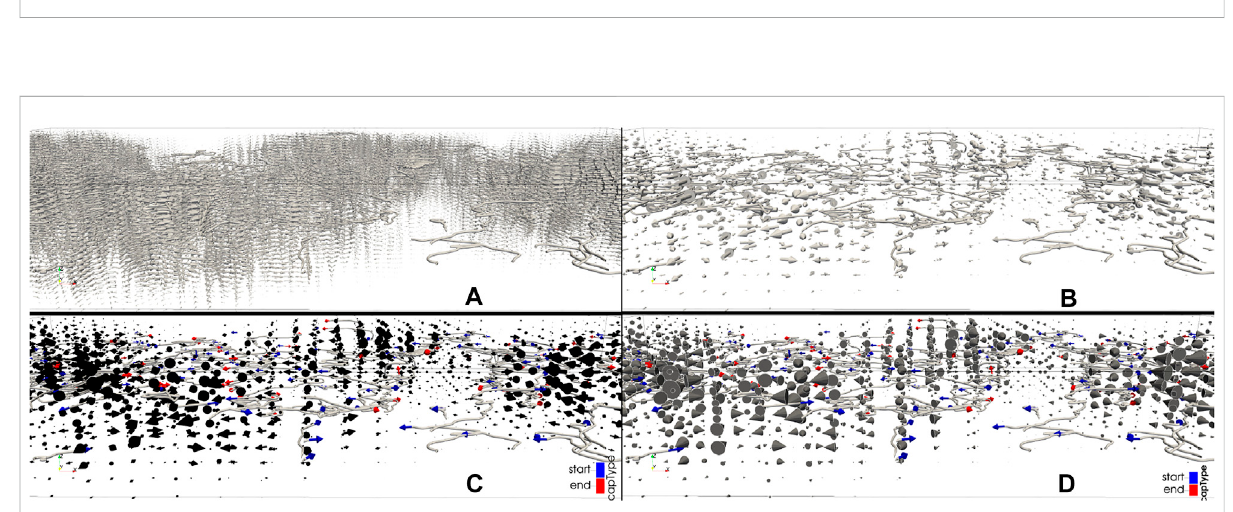
FIGURE 11 Typically, Lagrangian trajectories are line- or tube segments without direction indicators. Tip indicators (e.g., arrows) show a dominant fl ow directions (A) . For conclusively separating forward- and backward trajectories, the start- and end-tip are visually split from one another (such as by hue; b). For comparison, a plot with fully-coloured trajectories (C) is less effective in communicating startpoint and endpoint, while allocating more visual channels than necessary.